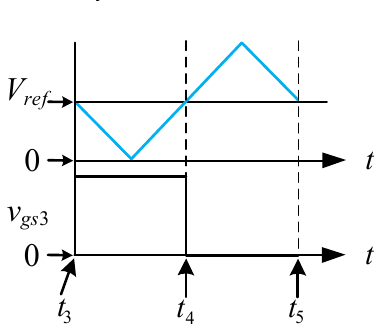
Figure 6. Current flow direction of stage I when switch S 1 is off.